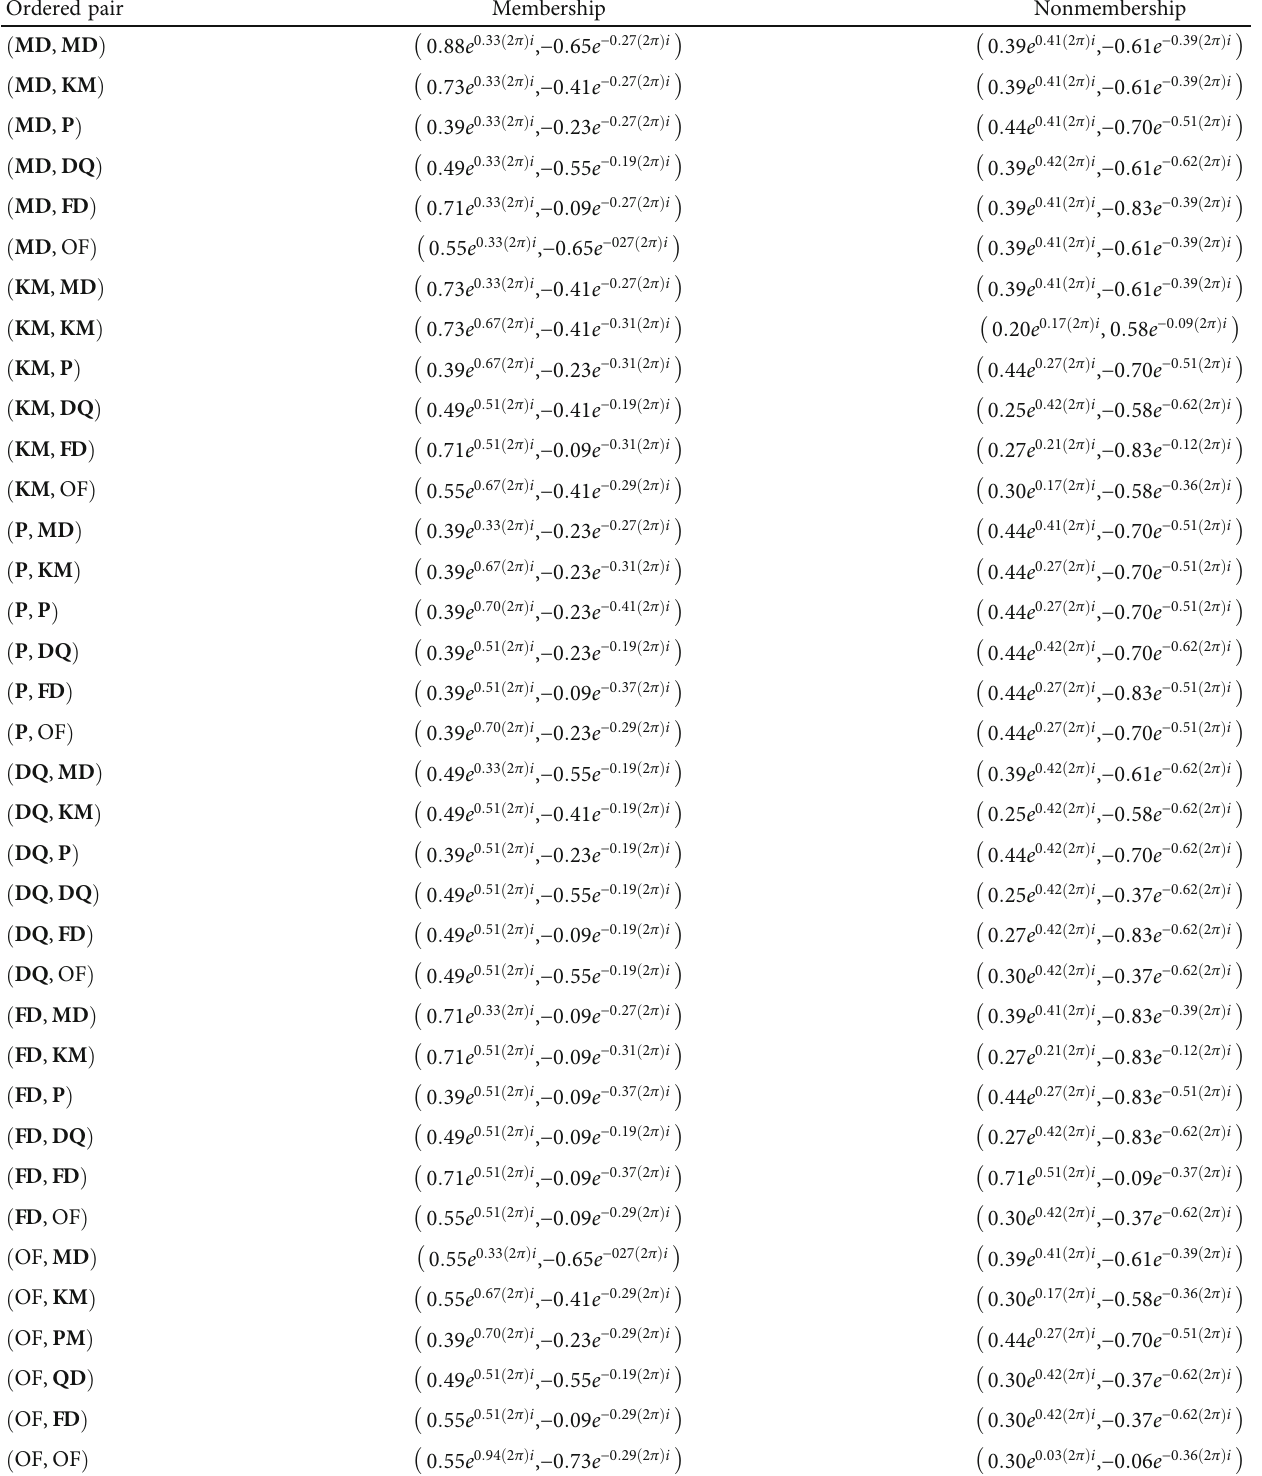
Table 1: Cartesian